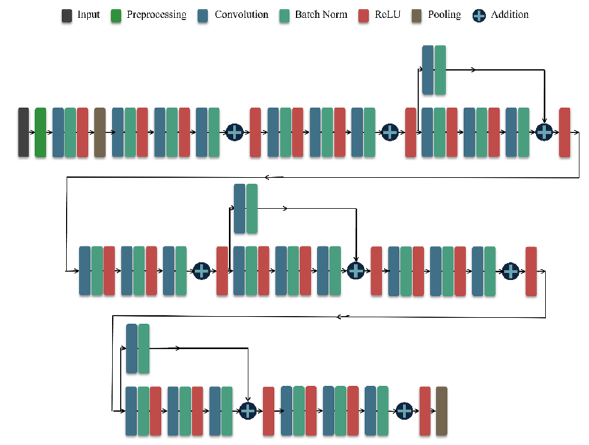
Figure 5. ResNet architecture. Figure 5. ResNet